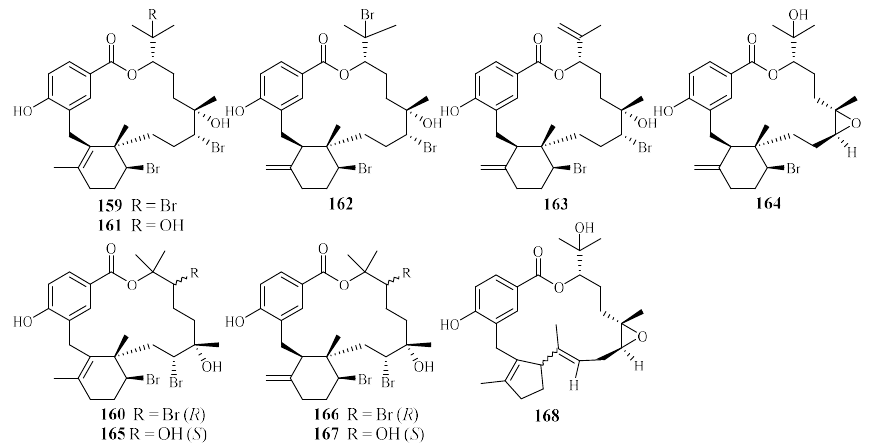
Figure 35. Compounds ( 151 – 158 ) from the red alga Callophycus serratus .